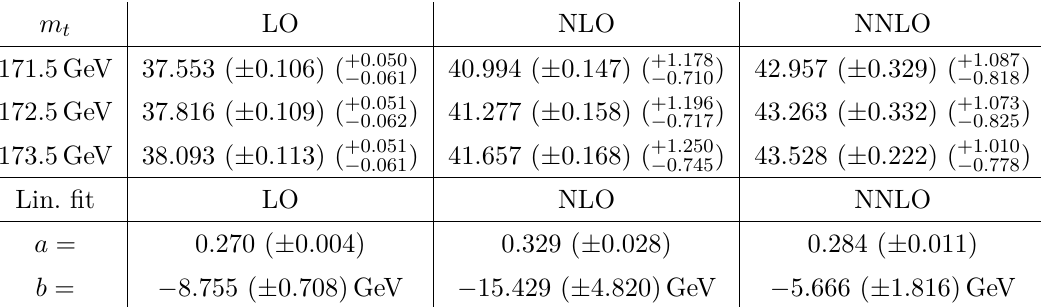
of E ( B ) . In practice, for values of m max